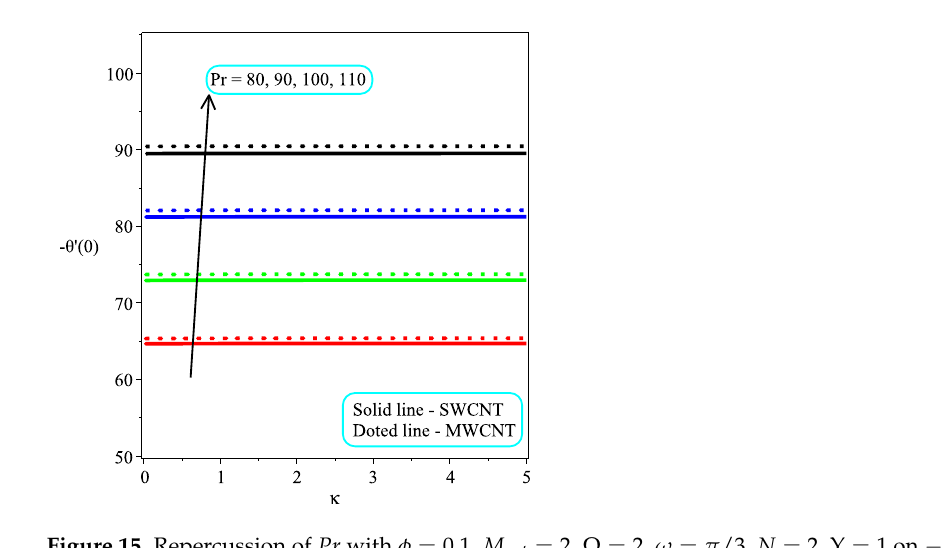
Figure 15. Repercussion of Pr with φ = 0.1, M egt = 2, Ω = 2, ω = π /3, N = 2, Υ = 1 on − θ (cid:48) ( 0 ) .